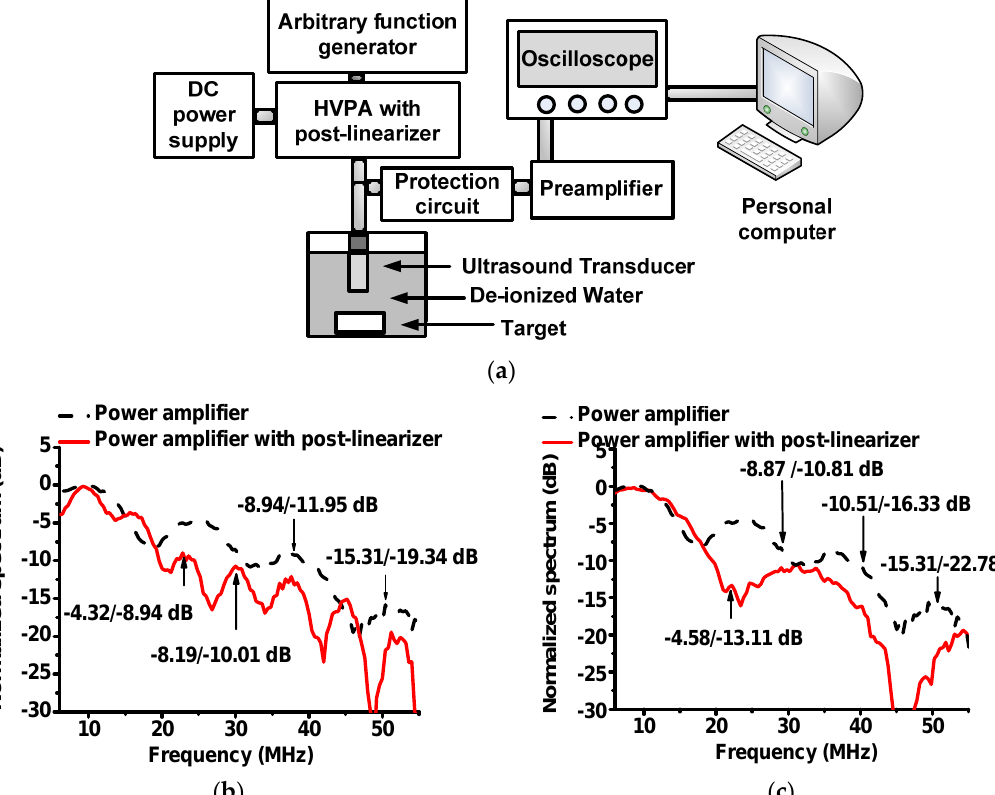
Figure 9. Block diagram of the UBM system and spectrum data of the echo signal generated by a 10 MHz ultrasound transducer with and without post ‐ linearizer circuit: ( a ) Block diagram of the UBM system; ( b ) 10 MHz, 20 ‐ cycle and 17 dB m input power, and 4 V DC voltage applied to the HVPA with and without post ‐ linearizer; ( c ) 10 MHz, 5 ‐ cycle and 26 dB m input power, and 4 V DC voltage applied to the HVPA with and without post ‐ linearizer.